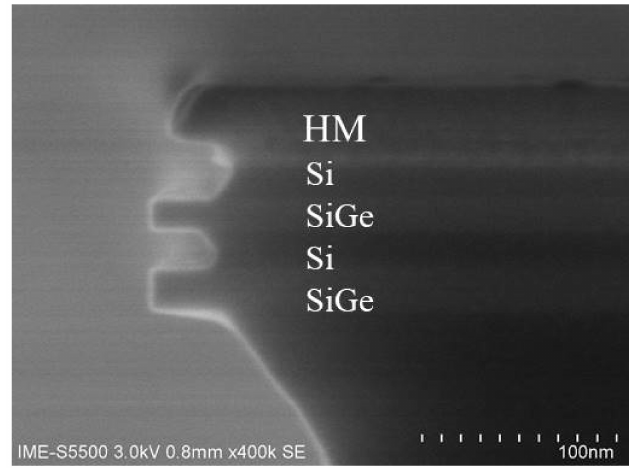
Figure 5. The SEM image of the selective etching of the Si 0.7 Ge 0.3 /Si multilayers stack utilizing the optimal ACT@ SG-201 solution at 40 ◦ C for 10